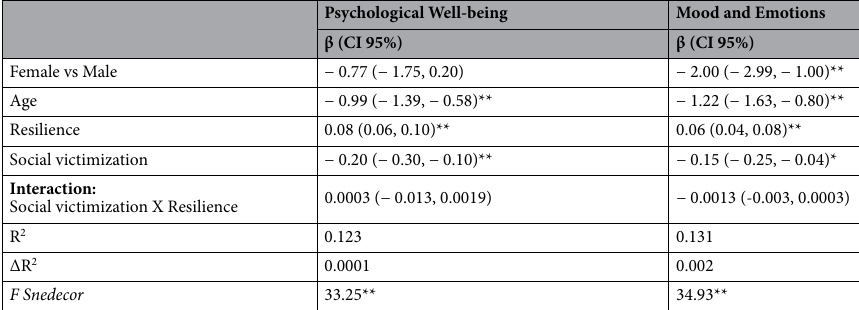
Psychological Well-being